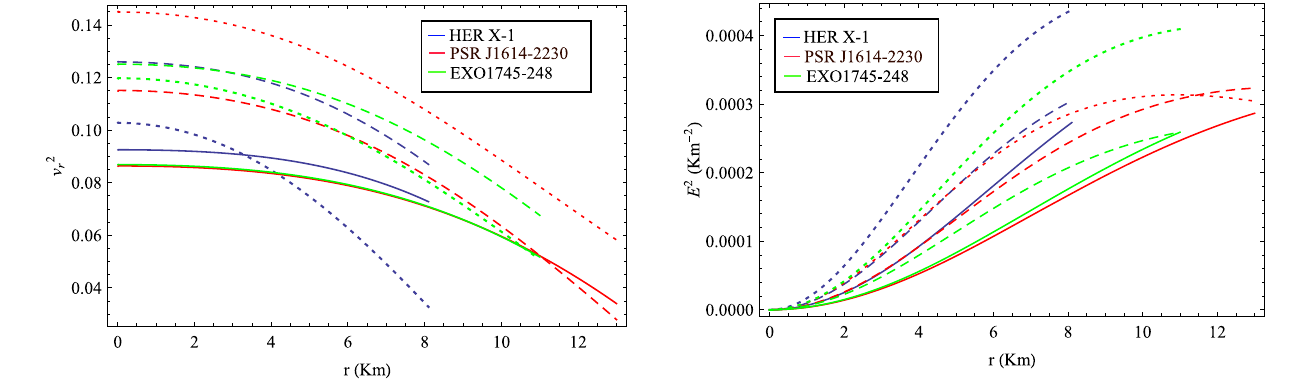
Fig. 6 Radial variation of square of the radial sound velocity ( v 2 r ) for different compact objects as indicated in the figure. Here plots with solid,dashedanddottedlinescorrespondto D = 4 , 5and6respectively. To obtain the plots we choose (i) α = 0 . 4, γ = 0 . 45 when D = 4; α = 0 . 3, γ = 0 . 25 when D = 5 and α = 0 . 25, γ = 0 . 2 when D = 6 for HER X-1, (ii) α = 0 . 4, γ = 0 . 5 when D = 4; α = 0 . 3, γ = 0 . 25 when D = 5 and α = 0 . 2, γ = 0 . 15 when D = 6 for PSR J1614-2230, (iii) α = 0 . 4, γ = 0 . 5 when D = 4; α = 0 . 3, γ = 0 . 2 when D = 5 and α = 0 . 2, γ = 0 . 25 when D = 6 for EXO1745-248